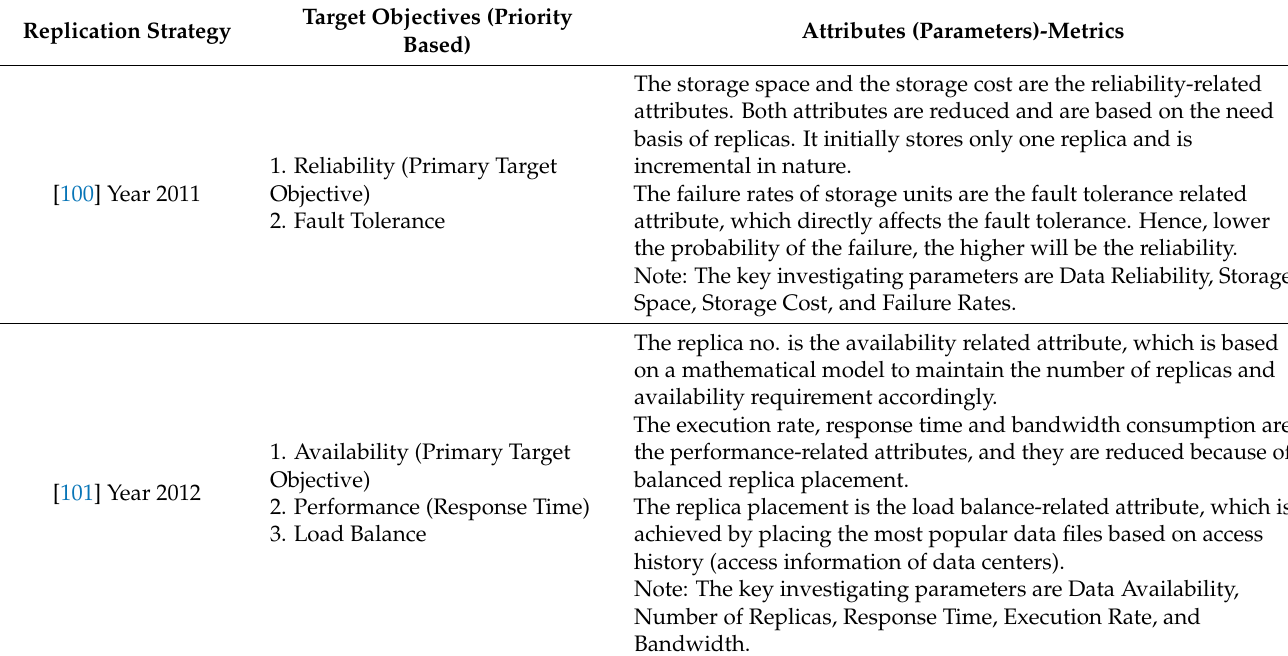
Table 4. Represents various target-oriented replication strategies with their target objectives based on their attributes, purpose, and metrics. Replication